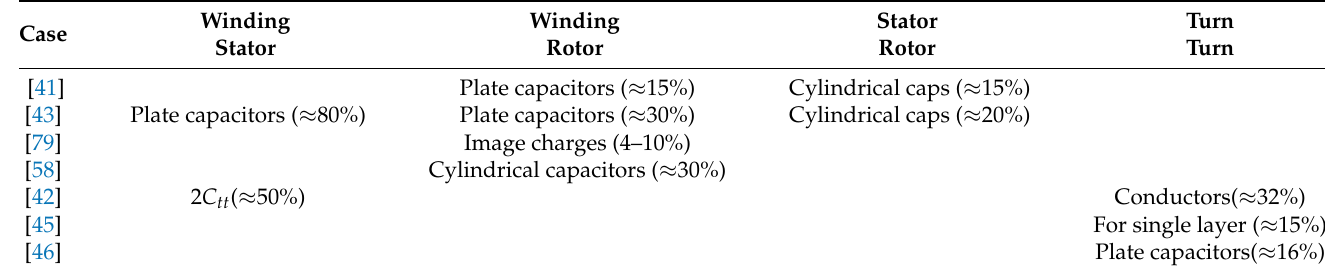
Table 4. Analytic Capacitance